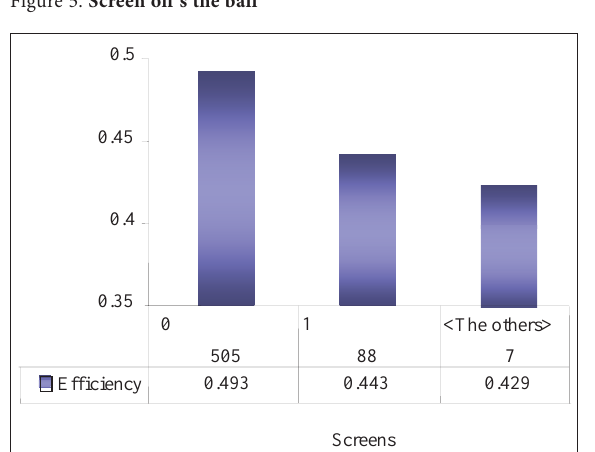
Figure 6. Screens on the ball